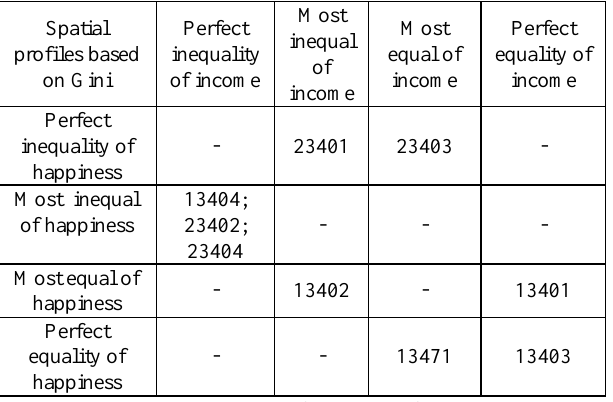
Table 6. Query Distribution of Spatial Profile based on